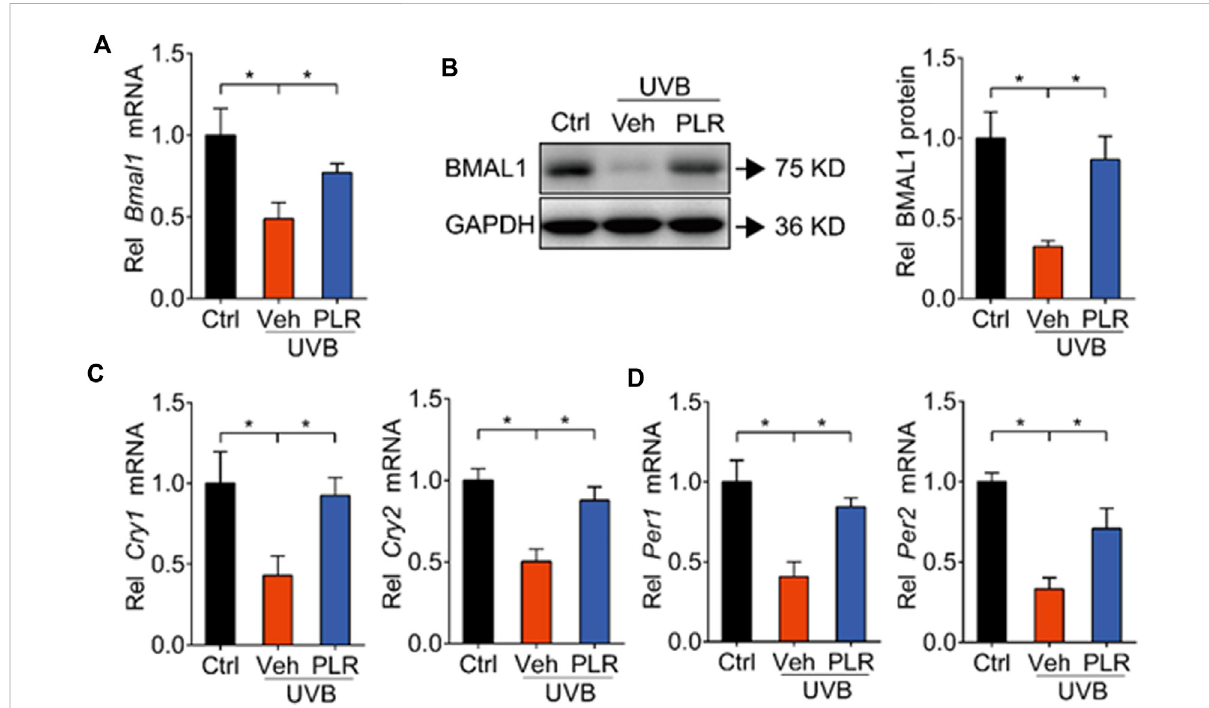
FIGURE 4 PLR modulates the expression of clock genes in aged skin. 400 mg/kg PLR was used to treat the skin of mice. RT-qPCR and Western blotting werecarriedouttodeterminetheexpressionlevelsofcoreclockgenesinmouseskin. (A) mRNAlevelof Bmal1 . (B) proteinlevelofBMAL1. (C) mRNA levels of Cry1 and Cry2 . (D) mRNA levels of Per1 and Per2 . Data are presented as mean ± SD ( n = 6). * p < 0.05. Ctrl, control; Veh,